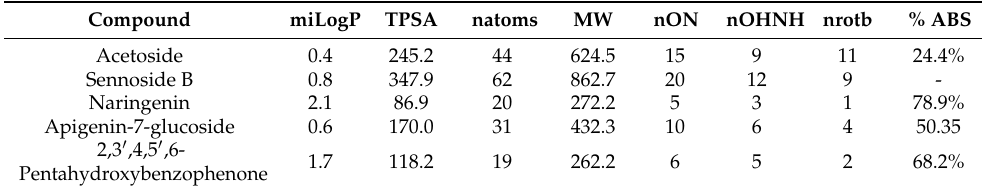
Table 4. Predicted molecular properties of the most active SARS-COV-2 Mpro inhibitors. Compound miLogP TPSA natoms MW nON nOHNH nrotb